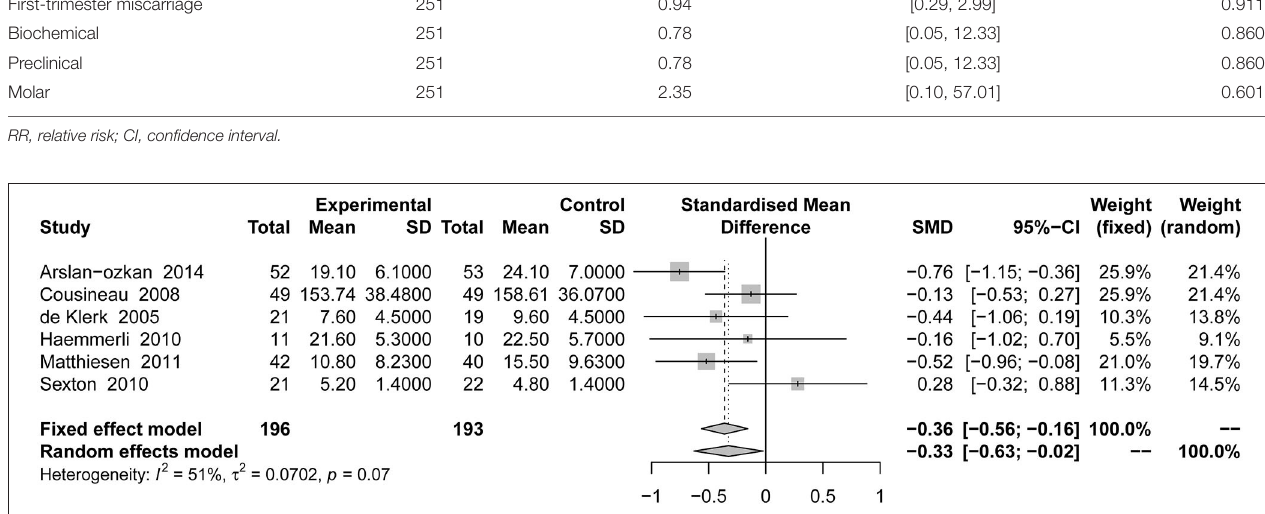
FIGURE 3 | Forest plot of total psychological scales associated with infertility in psychological outcome.